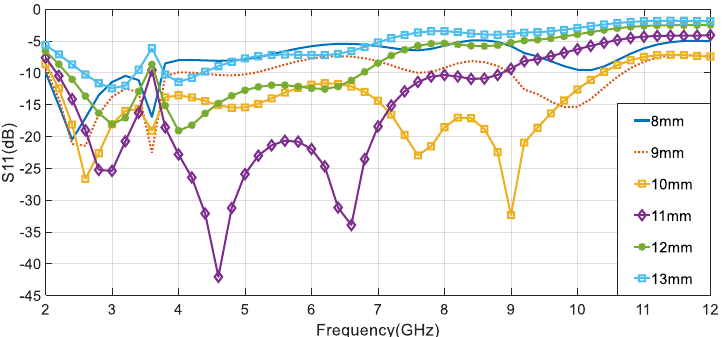
Figure 2. Simulated S 11 for ground length 8–13 mm.